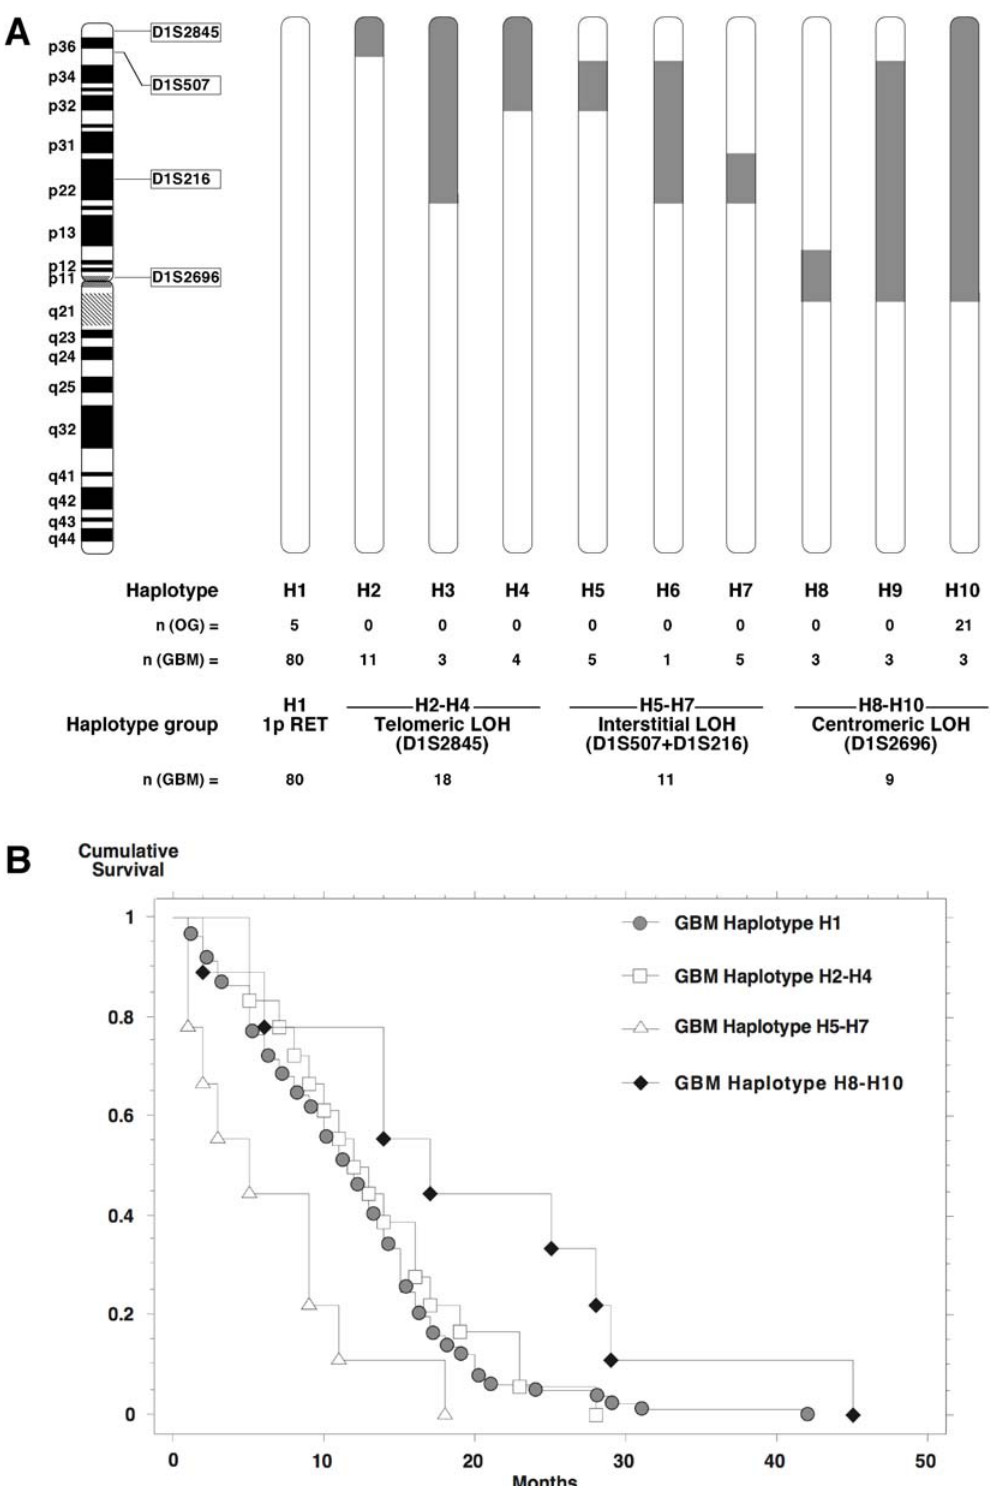
Figure 1. Glioma patients with centromeric 1p allelic loss show better survival. (A) Deletion patterns on chromosome 1p in GBM and OD. Somatic deletion mapping in 118 GBM and 26 OD WHO grades II and III was performed using 43 microsatellite markers. Four markers at deletion hotspots (D1S2845 at 1p36.3, D1S507 at 1p36.1, D1S216 at 1p22 and D1S2696 at 1p11) were selected to define chromosome 1p haplotypes. In GBM, 10 haplotypes were grouped into tumors with centromeric (H8–H10), interstitial (H5–H7) and telomeric (H2–H4) deletion patterns. In OD, only haplotypes H1 and H10 were observed. Chromosomal positions of 1p markers are shown on the left and areas of allelic loss are shown in grey. (B) Kaplan-Meier cumulative survival curve of the haplotype groups.